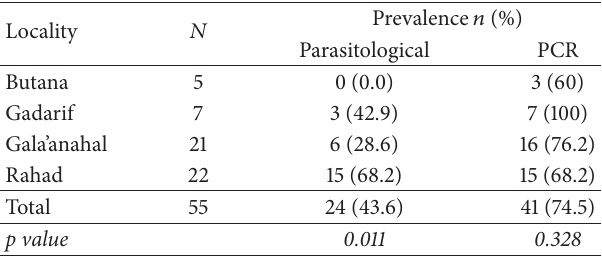
Table 1: Prevalence of camel piroplasmosis in the investigated localities.